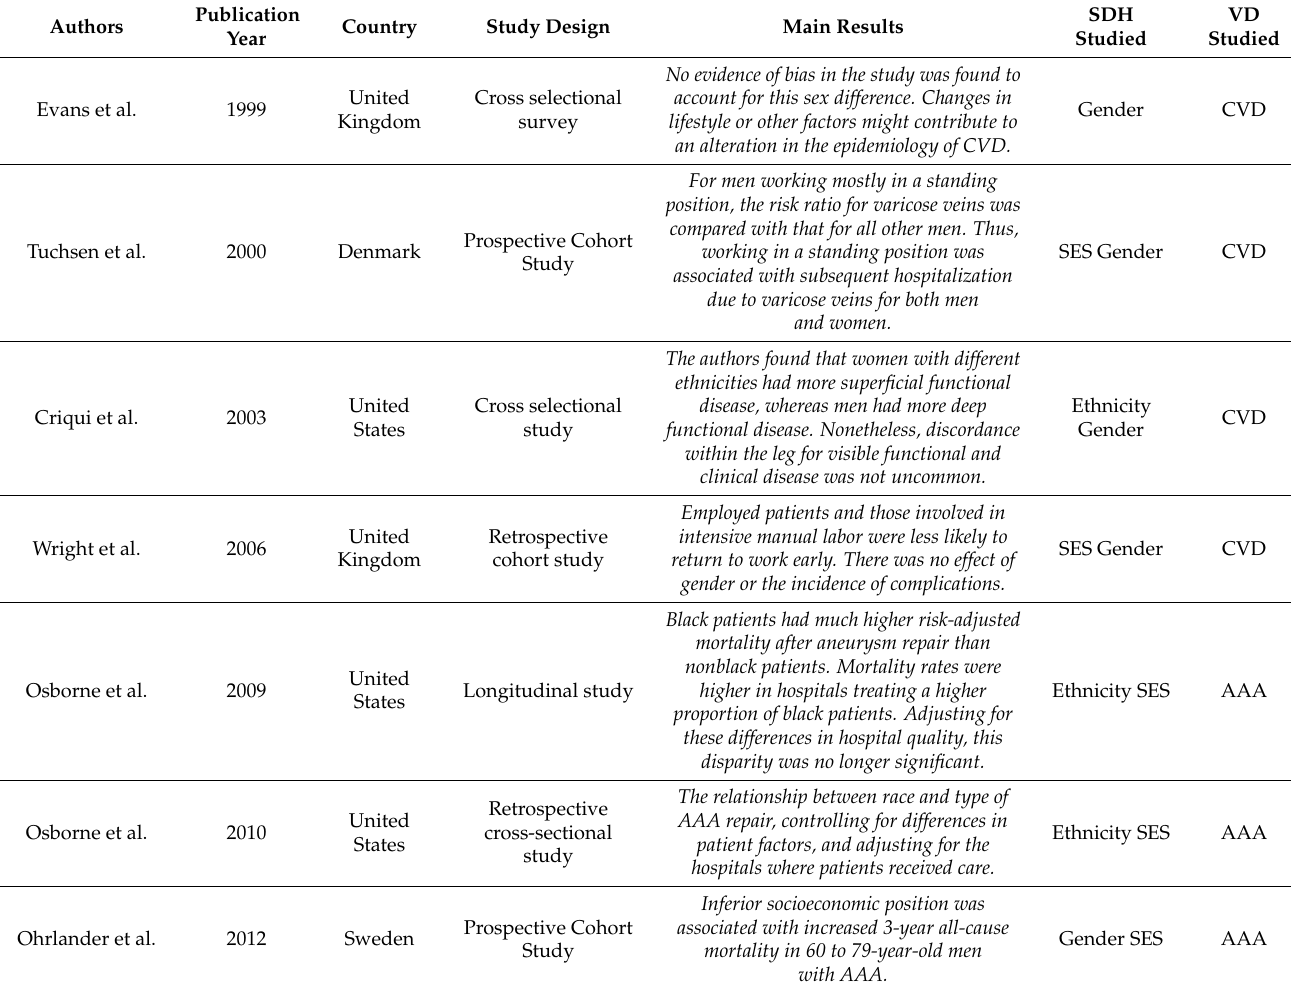
Table 4. General characteristics of the included